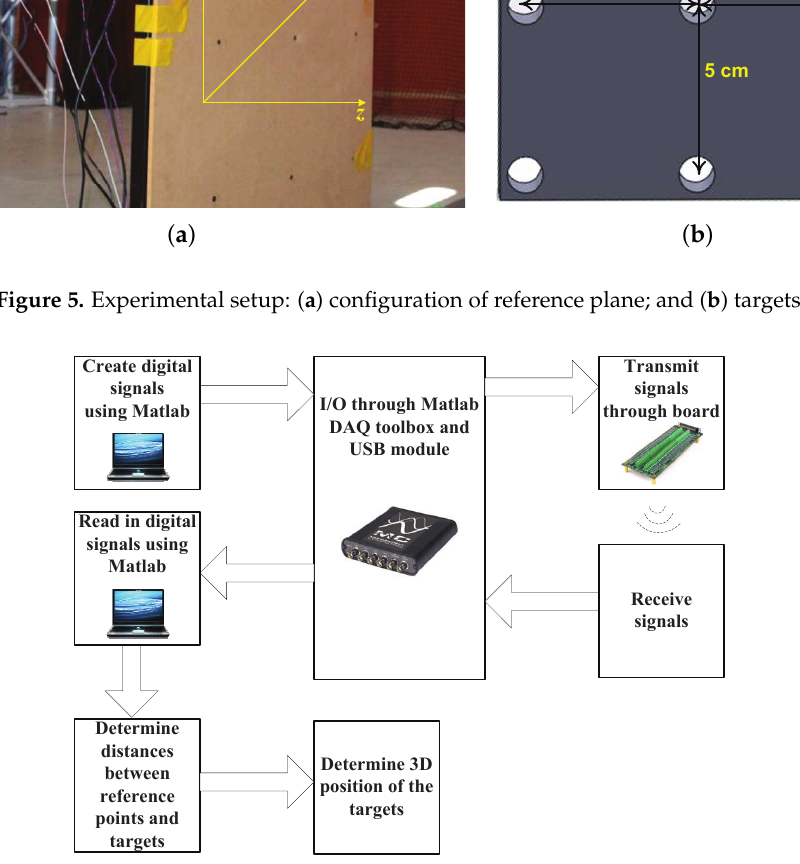
Figure 6. Illustration of the experimental